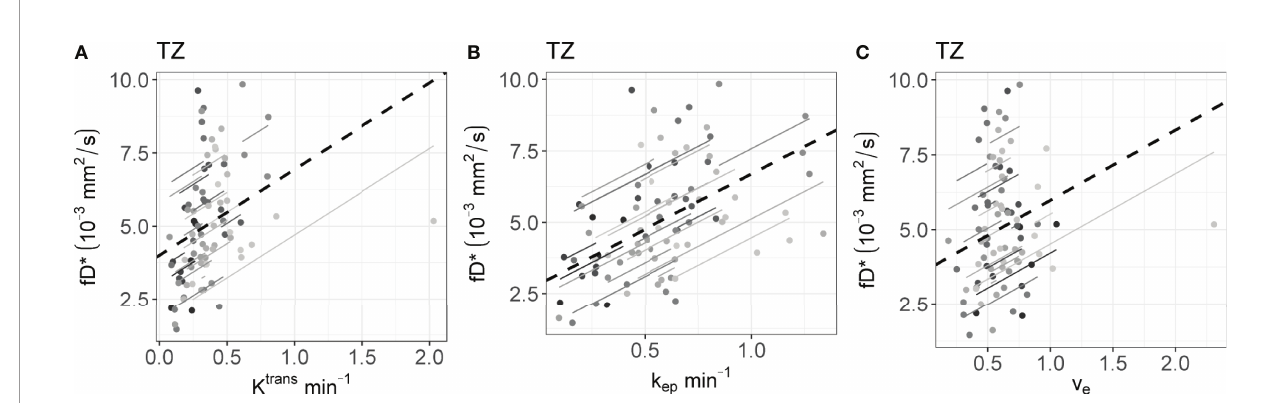
FIGURE 6 | The signi fi cant repeated measures correlation of fD* with the DCE parameters are shown. fD* only correlated signi fi cantly with DCE parameters in the (A – C) TZ. Each line shows the fi t for a single patient and the dashed black line shows the overall common